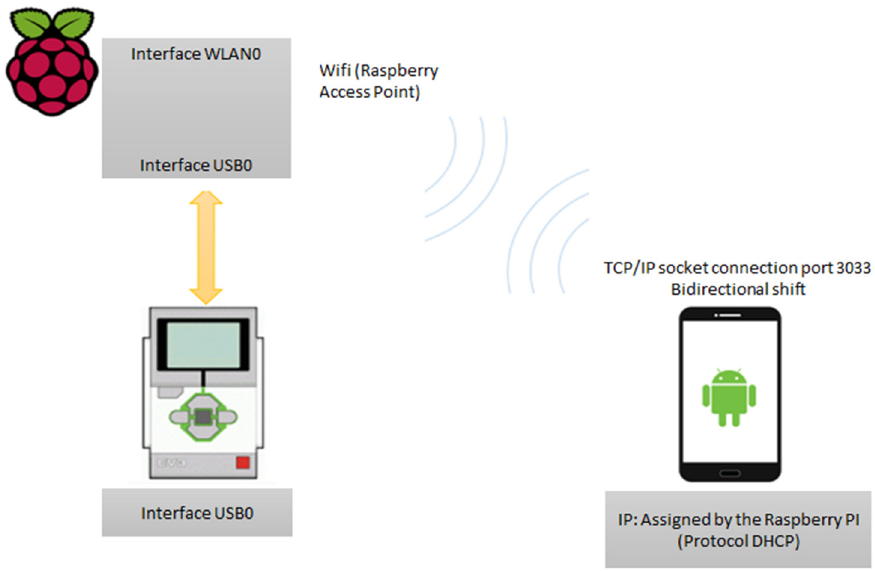
Figure 4. Communication system implemented in the experiment with specifications of interfaces, access points, connections, and communication protocols.